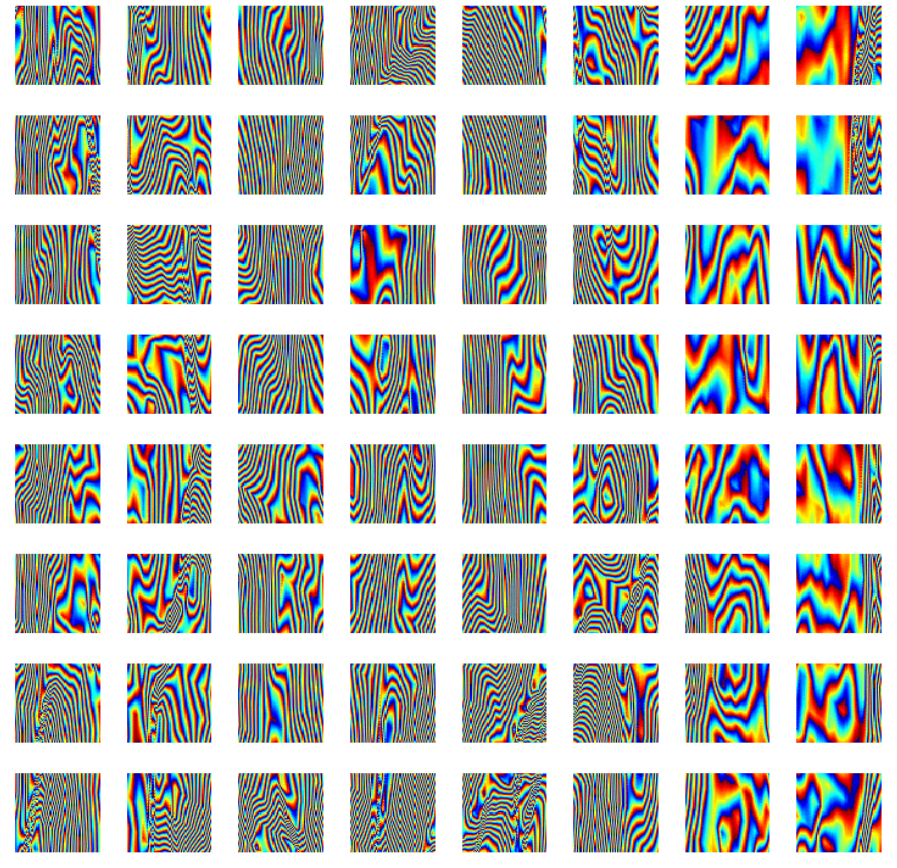
512 pixels interferogram split into 64 patches, 64 ×